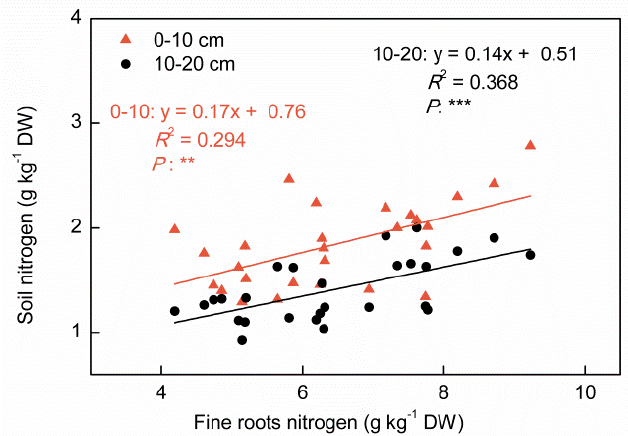
Figure 6. Correlation between 0–10 (red triangle) and 10–20 cm (black dot) soil nitrogen concentration and fine roots’ nitrogen concentrations (n = 27). ** and *** were indicated p < 0.01 and p < 0.001, respectively.